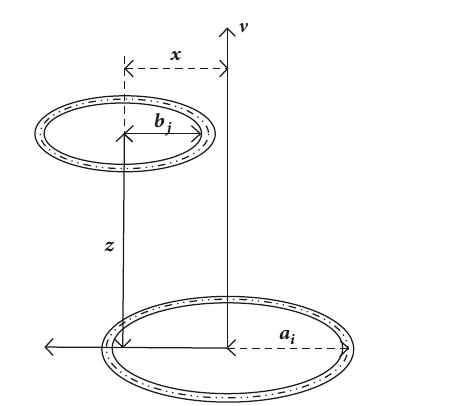
Figure 8: Calculated behavior for mutual impedance of coils with respect to